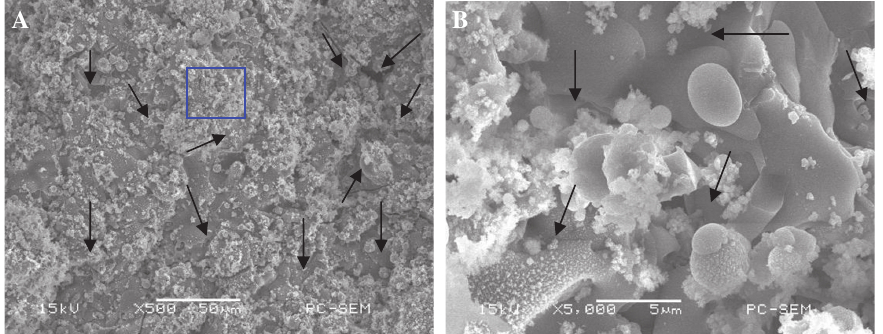
Figure 2 HA coating morphology (arrows represent the interstice).